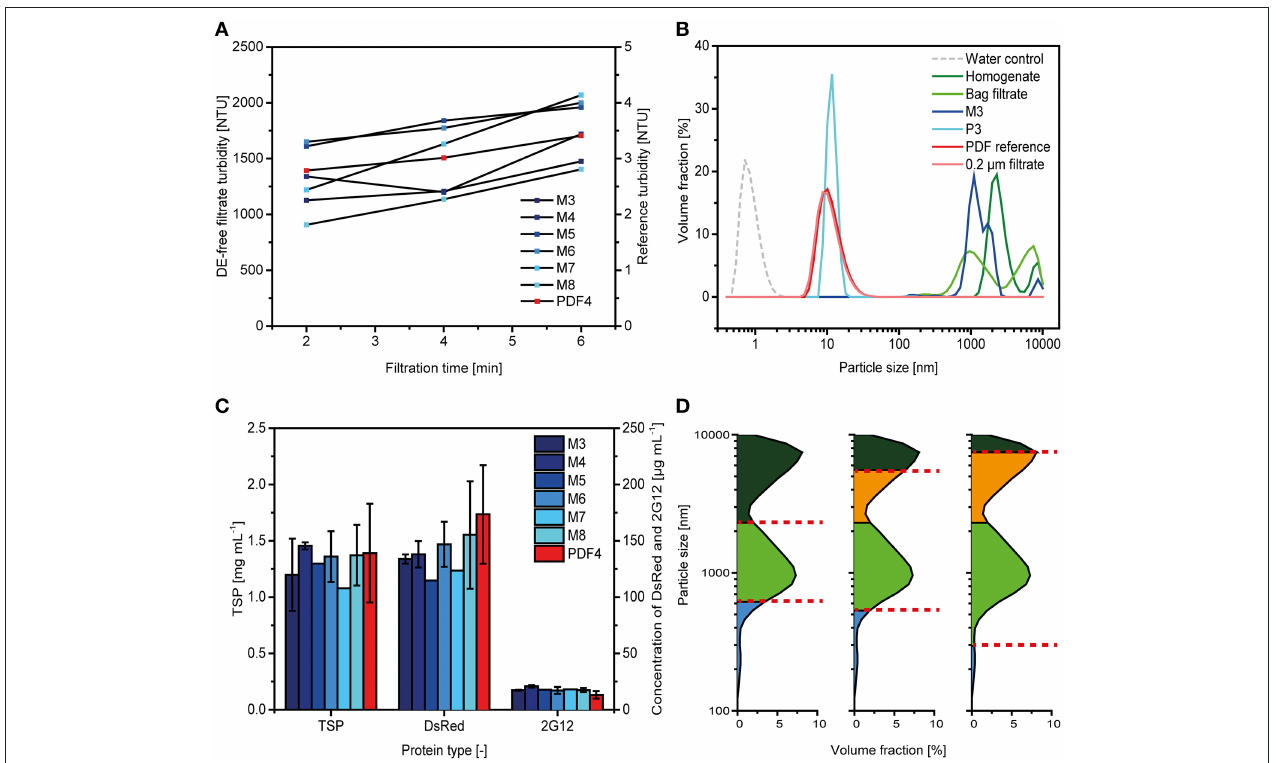
FIGURE 4 | Comparison of filters lacking diatomaceous earth with conventional depth filters. (A) Depth filtrate turbidities observed during clarification for DE-free filters and a DE-containing reference. (B) Particle size distributions determined for selected depth filtrates compared to those observed for preceding (homogenate, bag filtrate) and subsequent (0.2 µ m filtration) process steps. All measurements were taken with a Zetasizer NanoZS. (C) TSP, DsRed and 2G12 concentrations in different depth filtrates as determined by the Bradford method, fluorescence spectroscopy and SPR spectroscopy, respectively. Error bars indicate standard deviations ( n ≥ 3 ). (D) Particle retention by depth filters selected based on actual particle size distributions (F6, left), prediction by RN (PDF4, middle) and empirical data (F14, right). Particles retained by the first and second filter layers are colored dark green and green, respectively. Particles in the filtrate are colored blue and those not retained on the first filter layer due to suboptimal selection of the retention rate are colored